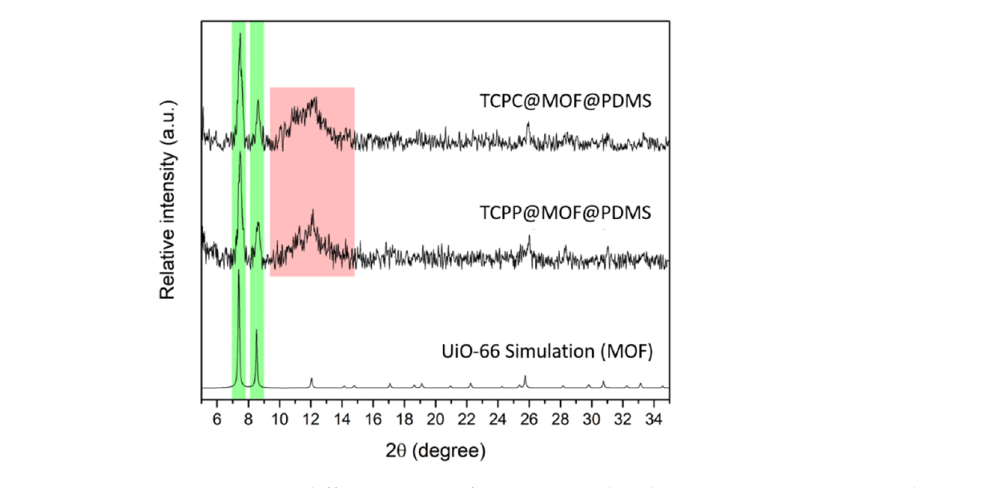
Figure 4. XRD diffractograms of UiO-66 simulated, TCPC@MOF@PDMS and TCPP@MOF@PDMS. Table 2. PL lifetime and values obtained for TCPC, TCPP, UiO-66(Hf), TCPC@MOF and TCPP@MOF using the materials-embedded